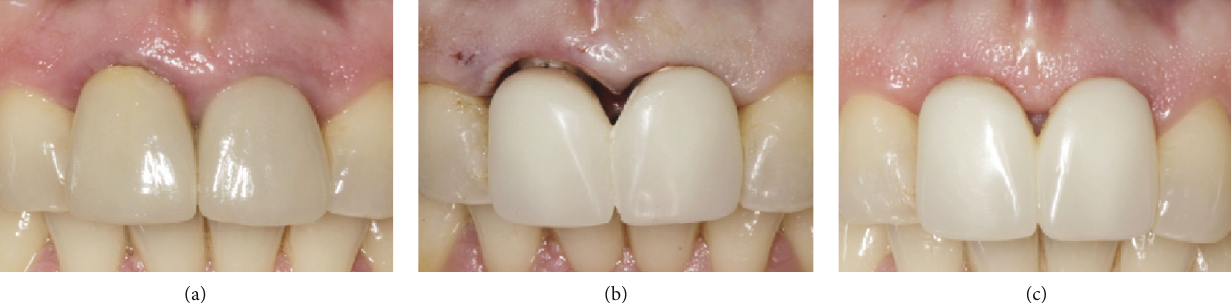
Figure 1: Adaptation of the soft tissue after the feather-edge preparation: (a) disparallelism of the gingival margin before BOPT; (b) right incisor shortened after BOPT; (c) coronal growth of the gingiva after one